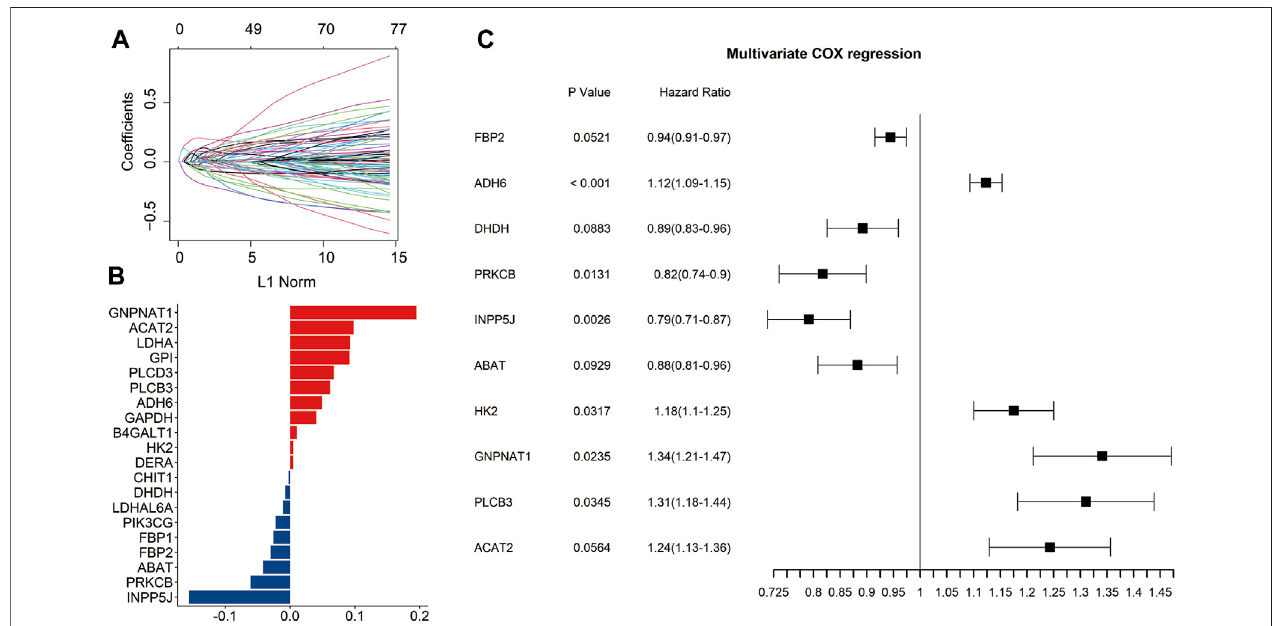
FIGURE 1 | Identi fi cation of the prognosis-related genes involved in glucose metabolism. Univariate Cox regression analysis identi fi ed 77 genes related to the prognosisofLUADpatients (A) .Thebarplotshowedthecoef fi cientsof20includedglucosemetabolism-relatedgenes (B) .MultivariateCoxregressionanalysisidenti fi ed ten genes to construct the signature (C)